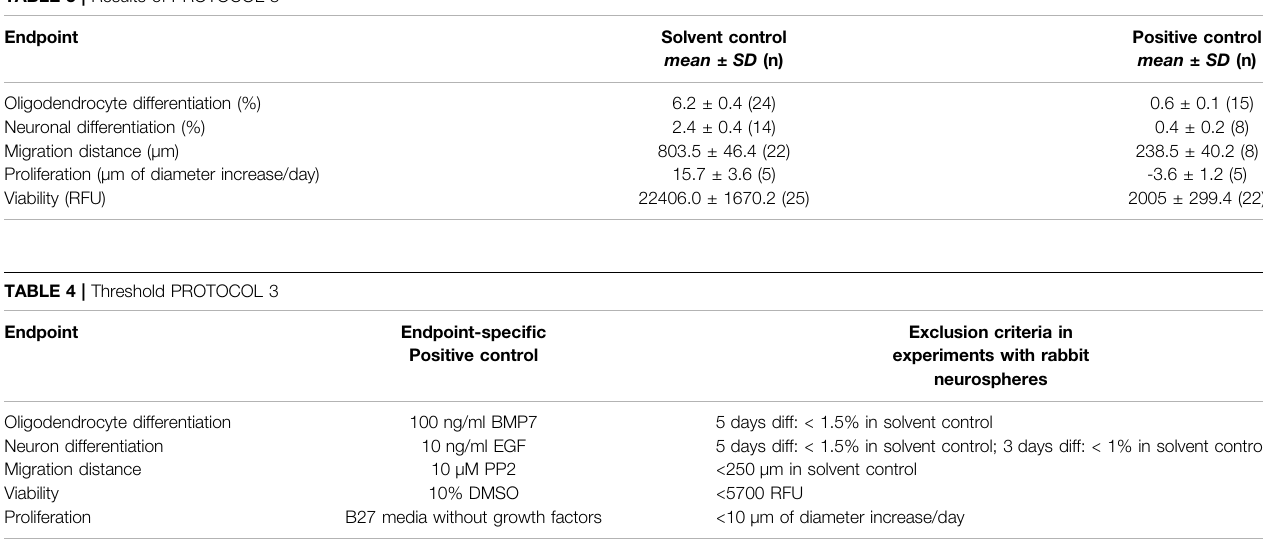
in Table 5 : Behavioral ontogeny, Table 6 : Golgi staining, and Table 7 : Astrocytes, microglia and oligodendrocytes IHC.